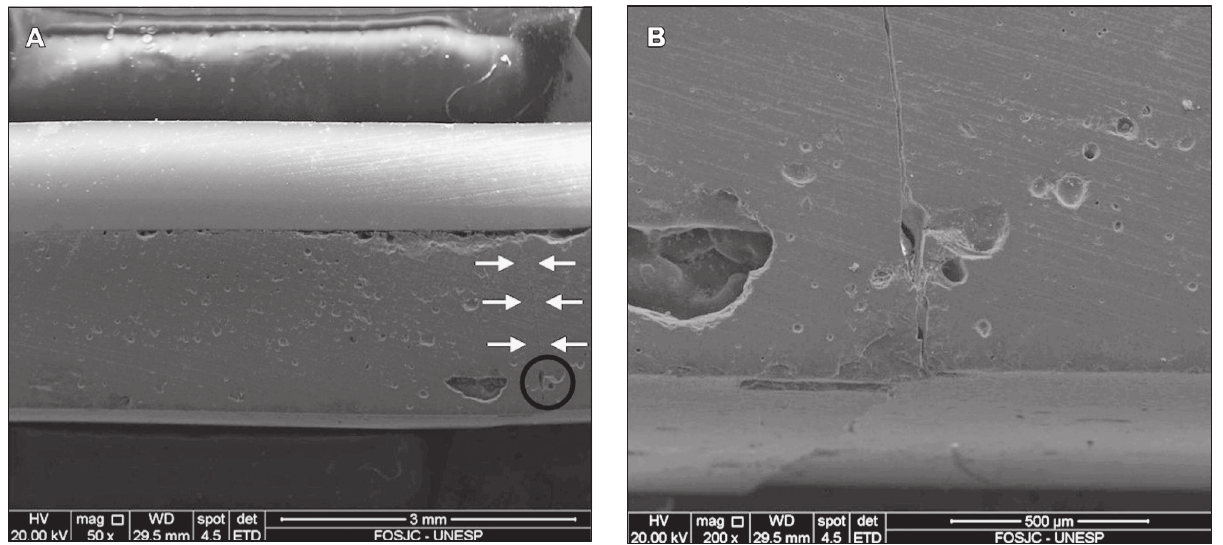
Figure 1- A: The crack starts on the tensile side and propagates to the interfacial area, as shown by the white arrows (50 × ). B: A closer view (200 × ) of the circle in Figure 1A. The tensile side is facing downwards.